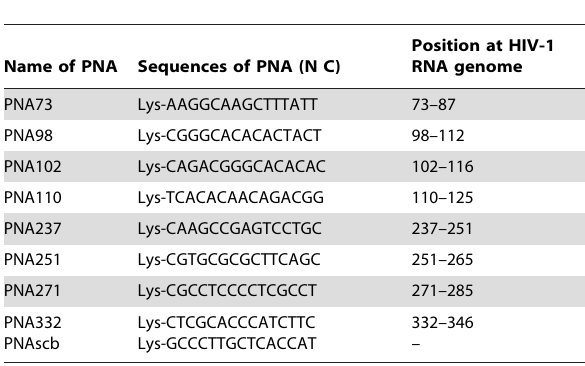
Table 1. Name and sequence of Peptide Nucleic Acid (PNA) targeted against different sites of 5 9 UTR